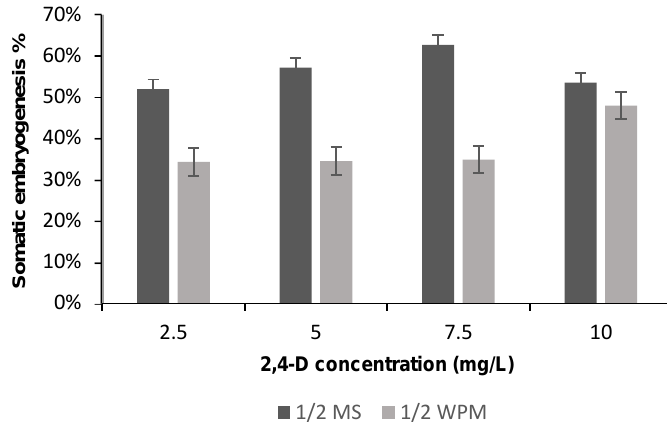
Figure 3. The means of the somatic embryogenesis percentage on di ff erent media supplemented with di ff erent 2,4-D concentrations after 6 weeks of subculture.